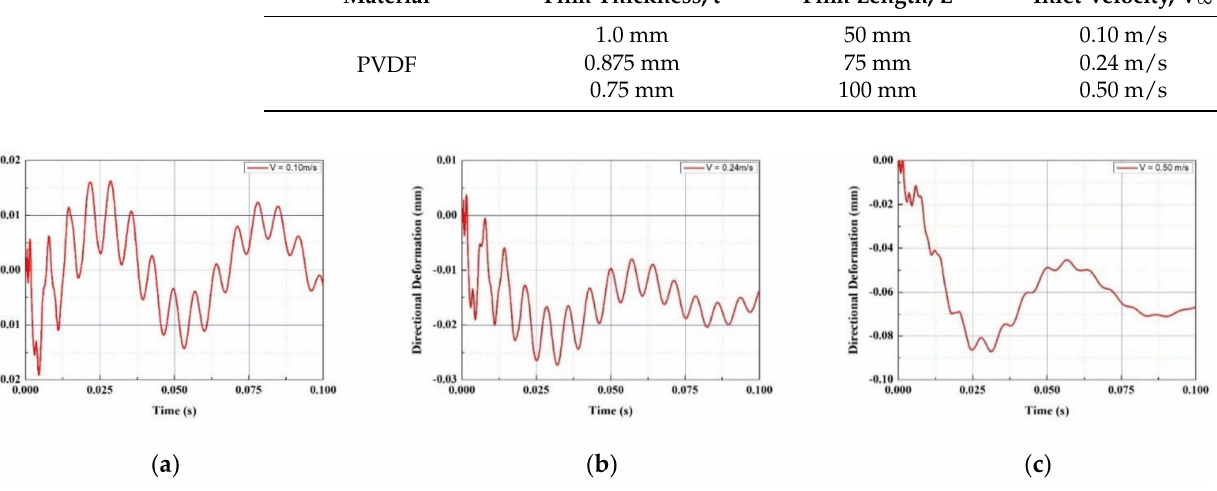
Figure 6. Vibration displacement with inlet velocity (V ∞ ): ( a ) 0.10 m/s; ( b ) 0.24 m/s ( c ) 0.50 m/s.